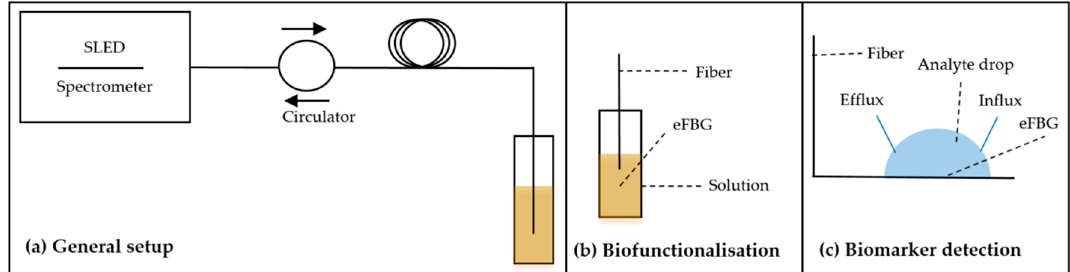
Figure 2. Overview of the used experimental setups. ( a ) General setup for signal processing; ( b ) Setup during bioassay formation; ( c ) Setup during analyte detection. For details, see text.